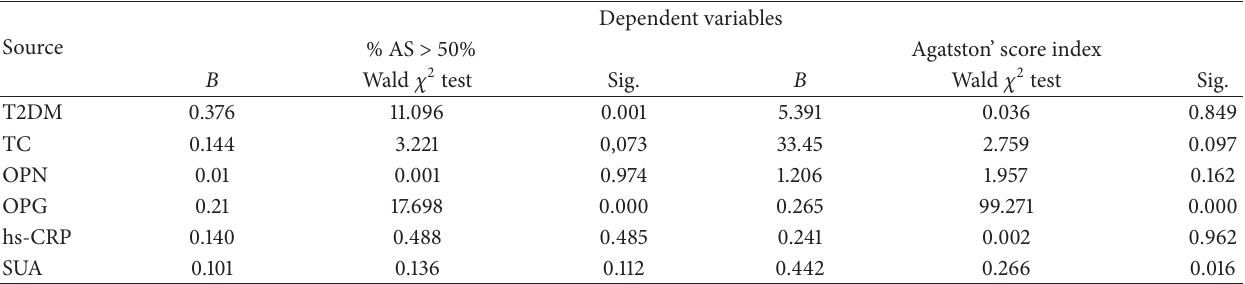
Table 2: Tests of generalized regression model for six parameters (type two diabetes mellitus, total cholesterol, osteopontin, osteoprotegerin, high-sensitive C-reactive protein, and serum uric acid) that potentially contributed to calcification of coronary arteries.